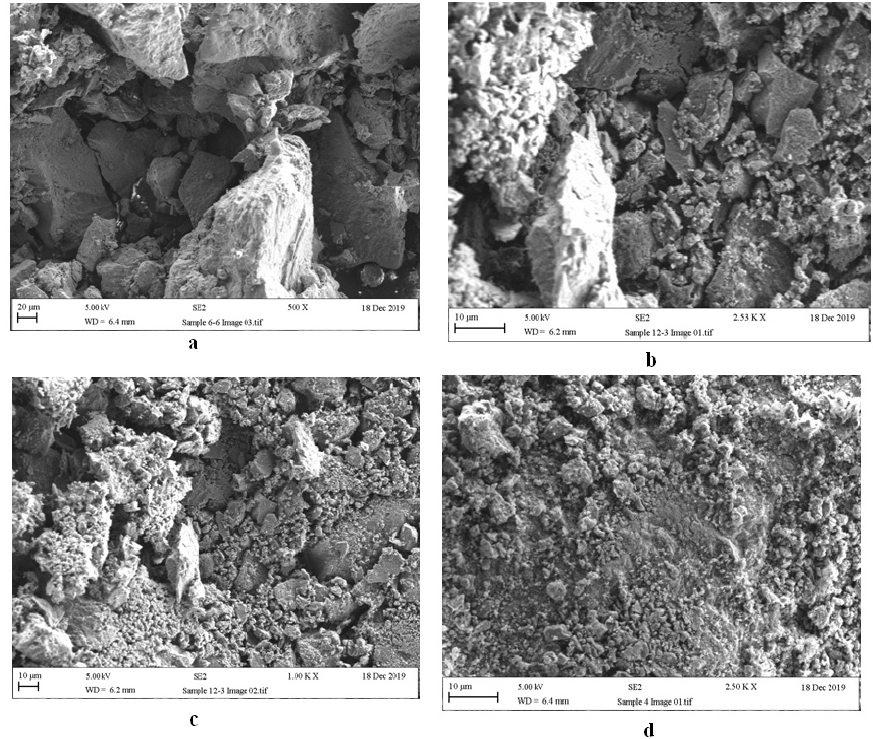
Figure 7. The micrograph of zeolites. Zeolites: ( a ) natural; with the maximum cation content: ( b ) In 3+ ; ( c ) In 3+ and Ga 3+ ; ( d ) with the minimum content of the In 3+ and Ga 3+ cations.